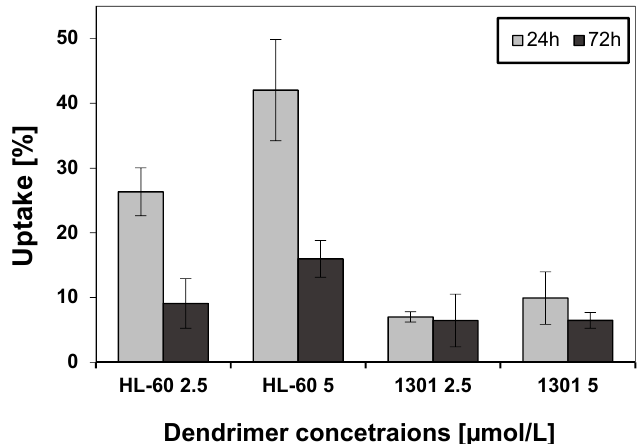
Figure 8. Flow cytometry of the uptake by HL-60 and 1301 cells of ruthenium terminated carbosilane dendrimer with FITC (CRD13-FITC). The results are mean ± SD, n = 3.